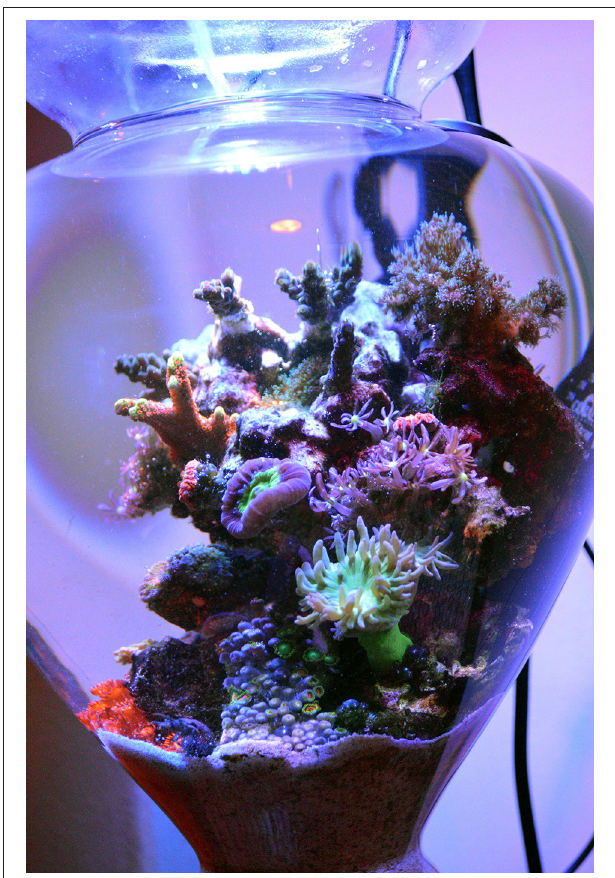
FIGURE 1 | A challenging and unconventional miniature 1.5-gallon reef aquarium can be grown in a glass vase. Home aquaria offers the home aquarist a chance to get close to oceanic organisms, appreciate their natural beauty, and even propagate them for sale and trade. Photo reproduced with the permission of the copyright holder [Matt